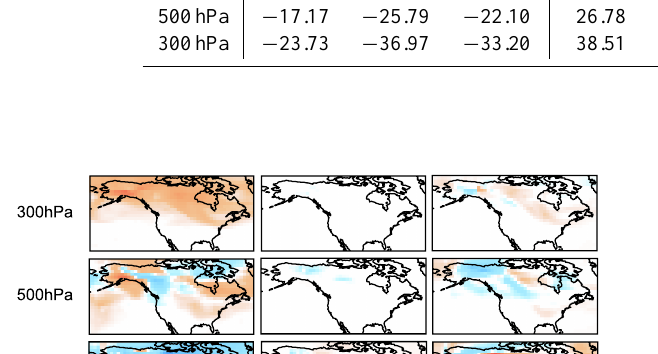
Table 2. Biomass burning emission-weighted mean meridional (V) winds (m/s), zonal (U) winds (m/s), and deep convective mass fluxes (10 − 2 Pa/s) over Alaska and western Canada during summer 2004. Positive values indicate eastward, northward and upward winds and fluxes. Meridional Wind (V) Zonal Wind (U) Deep Convective Mass Flux monthly 8-day synoptic monthly 8-day synoptic monthly 8-day synoptic Surface